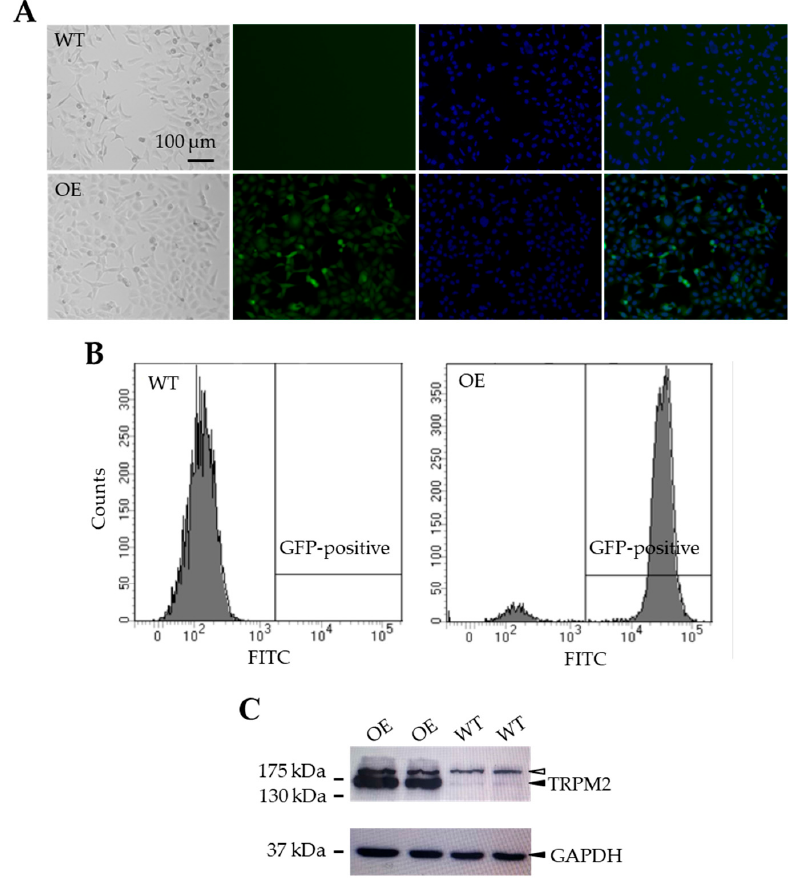
Figure 3. Generation of TRPM2-overexpressing SH-SY5Y stable cells. ( A ) Represent bright field and fluorescence images of wild-type (WT) and TRPM2-overexpressing (OE) cells. ( B ) Flow cytometry analysis of green fluorescent protein (GFP) expression in the WT (left) and OE (right) cells. ( C ) Western blots showing expression of TRPM2 and glyceraldehyde 3-phosphate dehydrogenase (GAPDH) in the WT and OE cells. The solid arrowheads in the top and bottom panels indicate TRPM2 and GAPDH, respectively. The empty arrowhead in the top panel indicates a non-specific and high molecular weight protein, which was present in both the WT and OE cells with a similar level. There was a strong increase in the TRPM2 protein expression in the OE cells (lanes 1–2) as compared to the endogenous TRPM2 protein expression in the WT cells (lanes 3–4), where the GAPDH expression level was similar in both cell types.